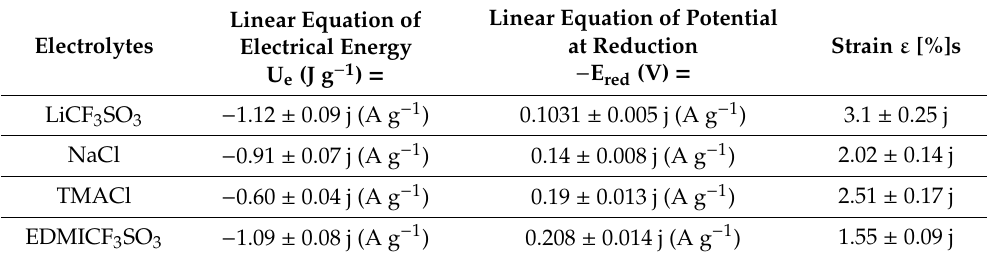
Table 2. Linear sensing equations of the flowing current from: the consumed electrical energy U e , the material potential after reduction, E red, and the maximum strain variation, ε , using PPy-PEO / DBS films in solutions of LiCF 3 SO 3 , NaCl, TMACl, and EDMICF 3 SO 3 under the conditions described in Figure